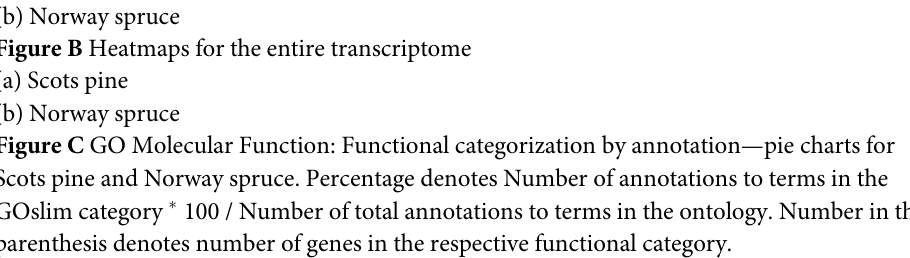
Figure B Heatmaps for the entire transcriptome